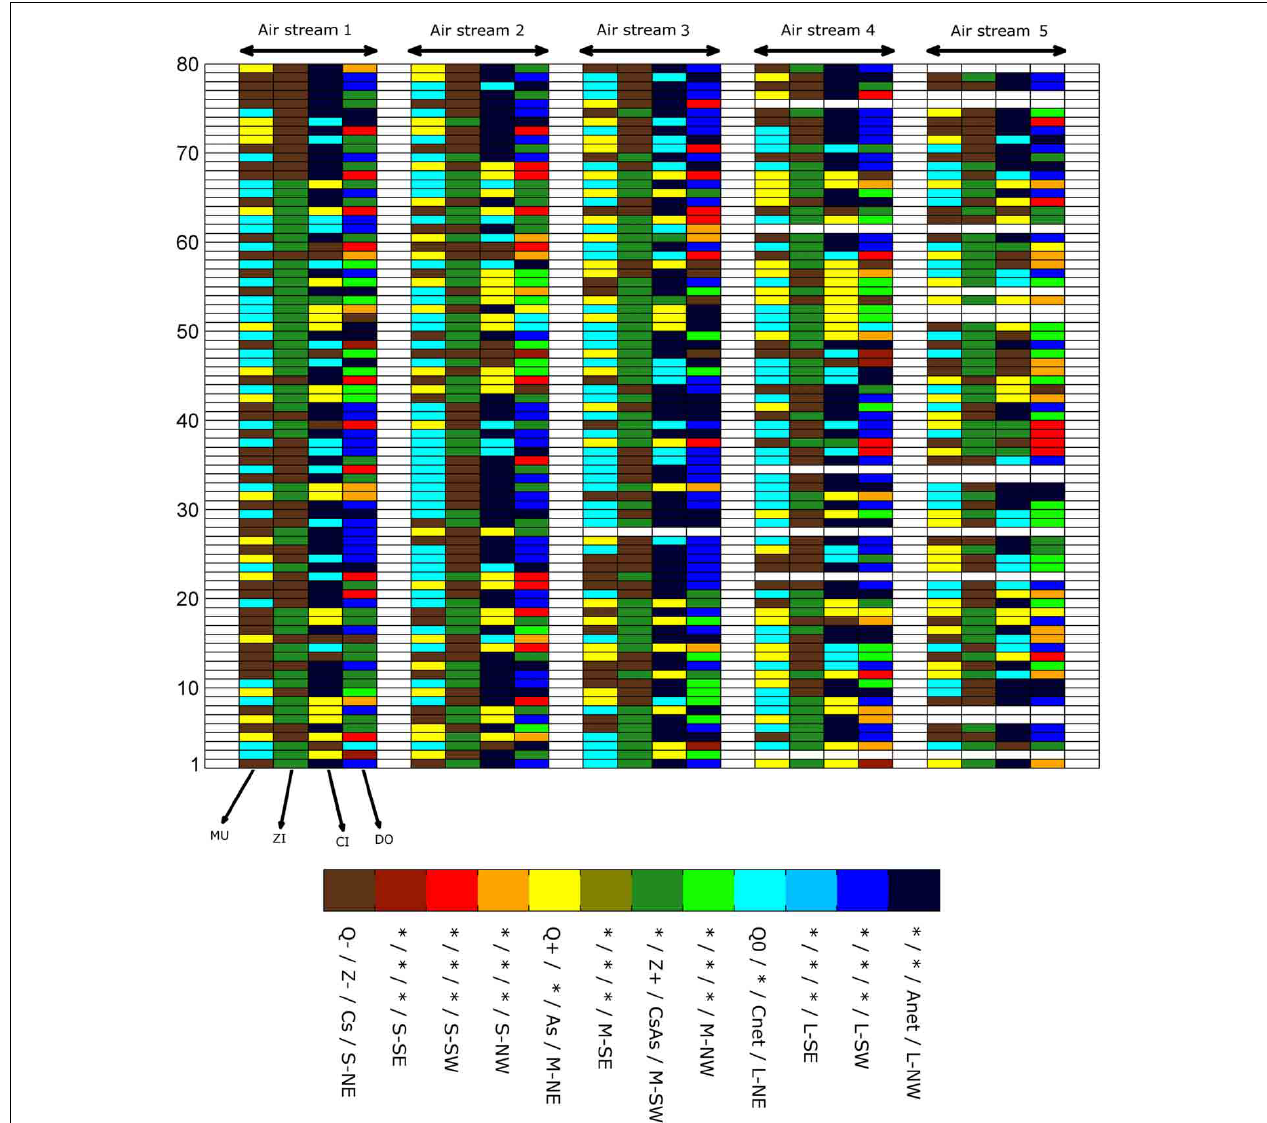
FIGURE 6 | Representation of the final catalog for 80 first days (from 01/12/1999 to 18/02/2000). Each day is characterized by at most five air streams and each air stream can be described by four flow properties (MU, ZI, CI, and DO), as discussed in Section A New Classification Based on